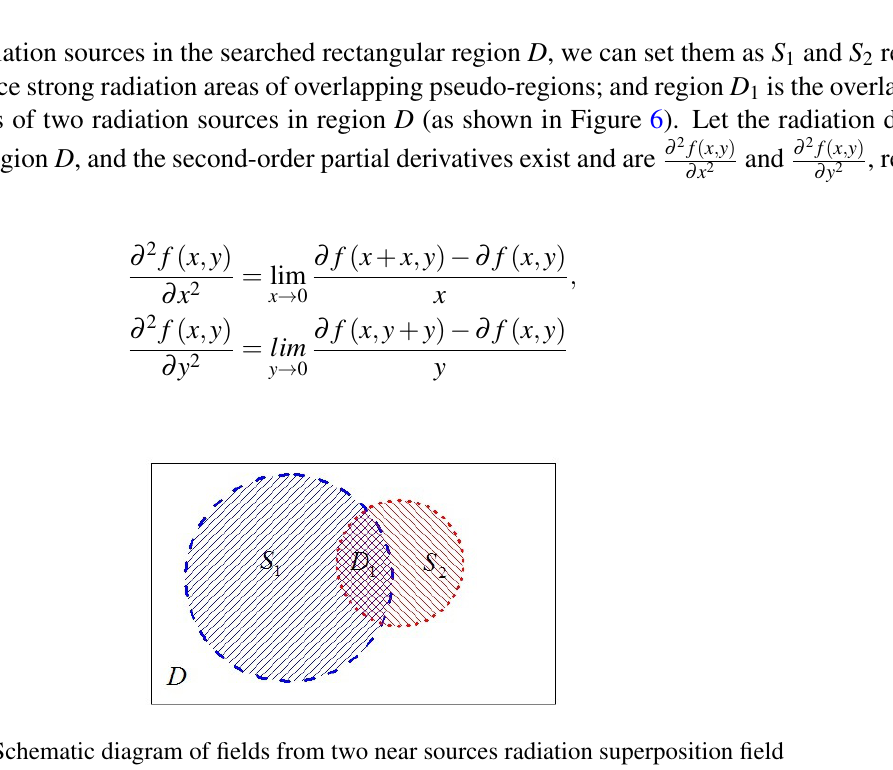
Fig. 6 Schematic diagram of fields from two near sources radiation superposition